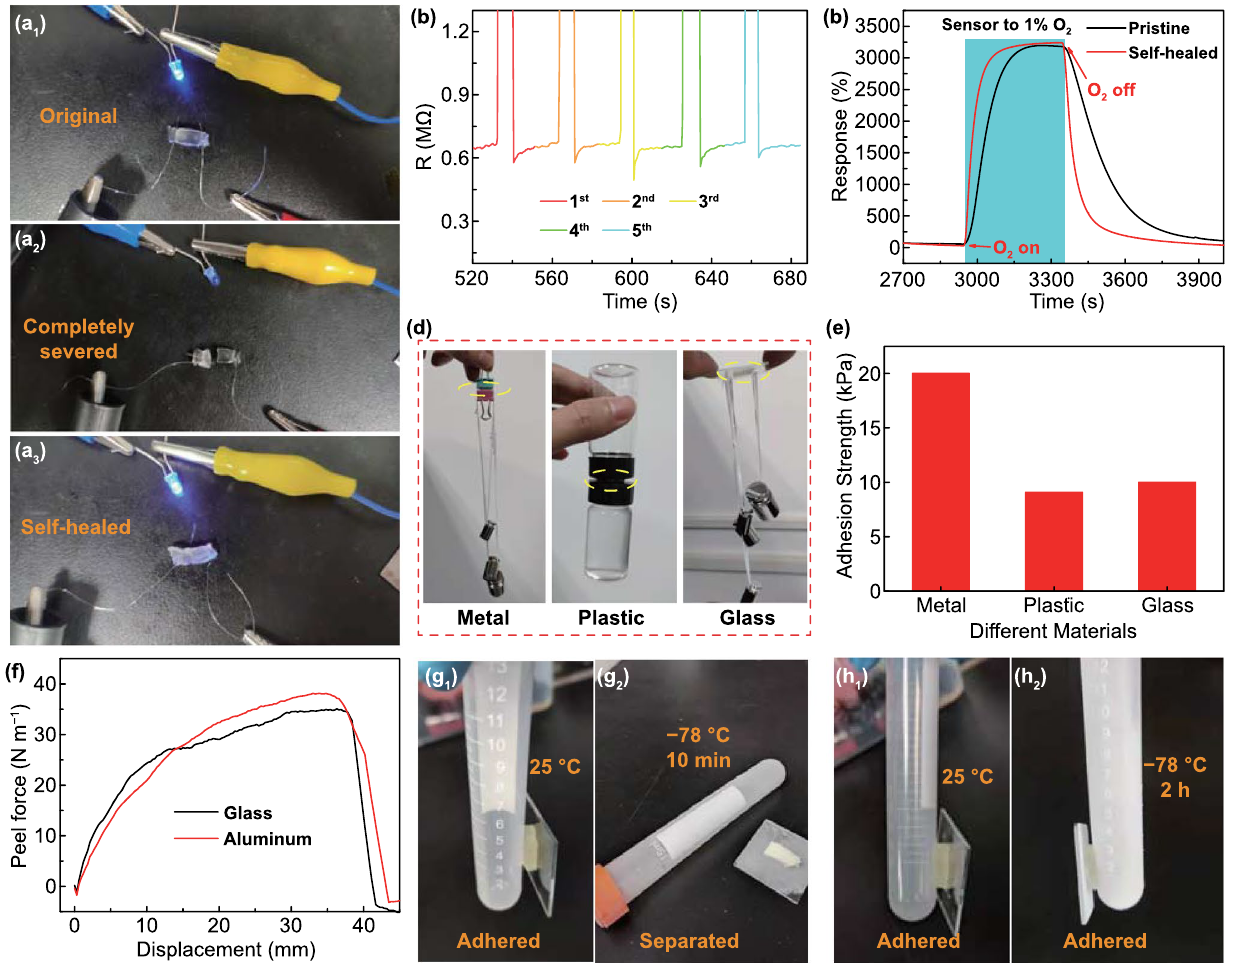
Fig. 3 Self-healing and self-adhesive abilities of organohydrogel. a The change of on and off states of the LED indicator in the series circuit when the organohydrogel was in the states of (1) original, (2) completely severed, and (3) self-healed. b Time evolution of cyclical electrical self-healing processes of organohydrogels by real-time resistance measurement. c Dynamic responses of the sensor to 1% O 2 in the pristine and self-healed states. d Photographs showing the organohydrogel (marked by the yellow circle) adhered firmly to various materials: metals, plastic, and glass. e The adhesion strength of organohydrogel on different substrates. f Peel force versus displacement curves of organohydrogel when adhered on different substrates. Photographs depicting g the untreated hydrogel could and could not adhere to the plastic centrifuge tube at 25 and -78 °C, respectively, whereas h the organohydrogel adhered firmly to the plastic centrifuge tube at both